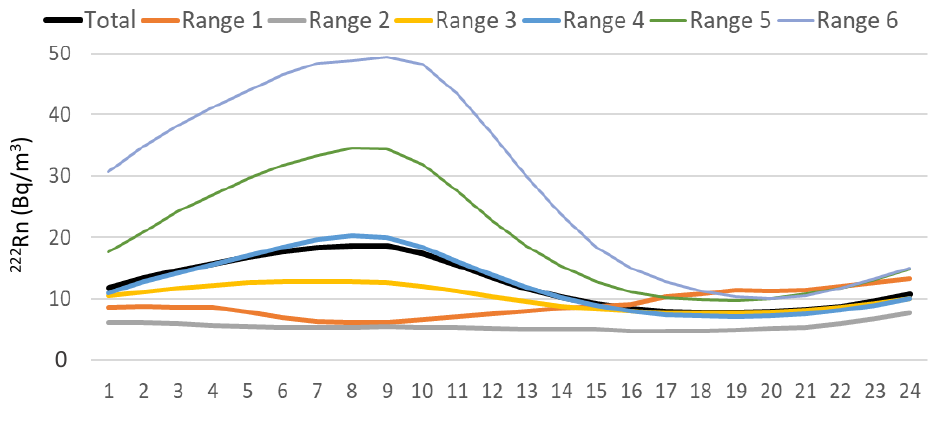
Figure 5. Diurnal composite of average hourly radon concentrations for each range of different daily concentrations in Bilbao.